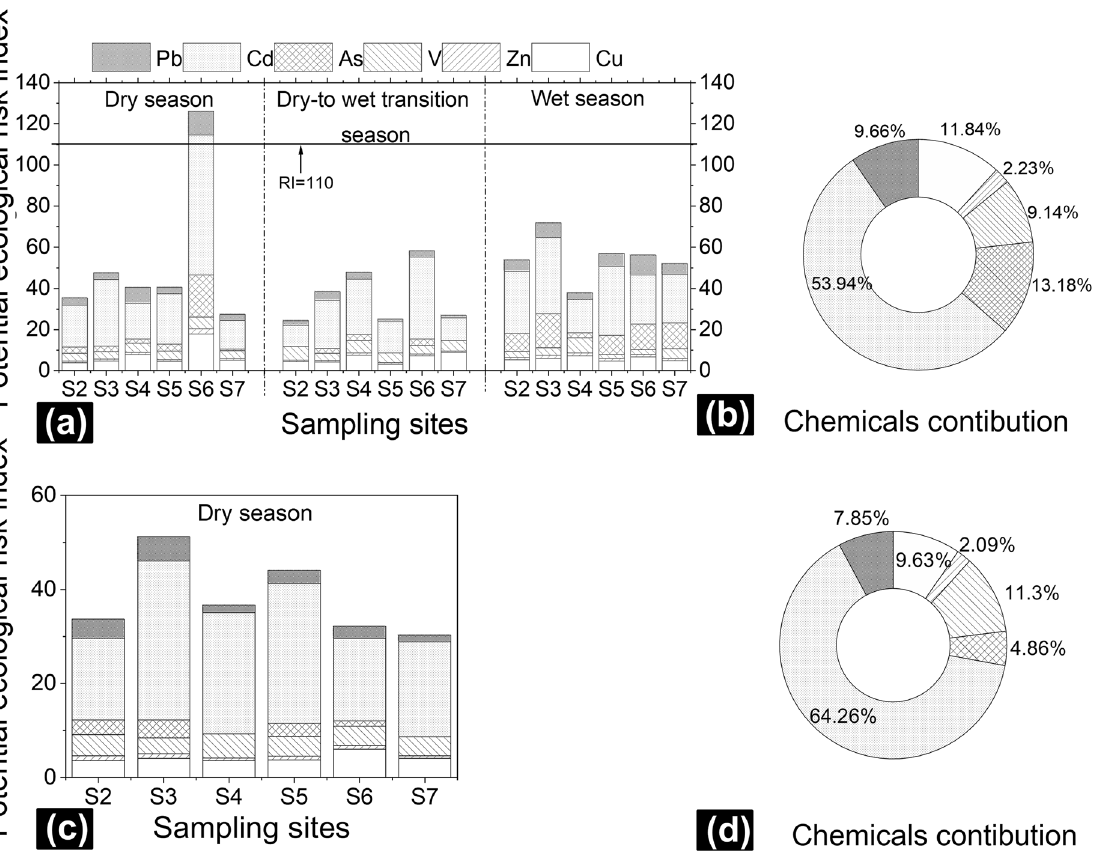
Figure 2. Potential ecological risk index of soil ( a ) and sediment ( c ) calculated by the Hakanson method in the study area. Each TE contribution to the index of soil ( b ) and sediment ( d